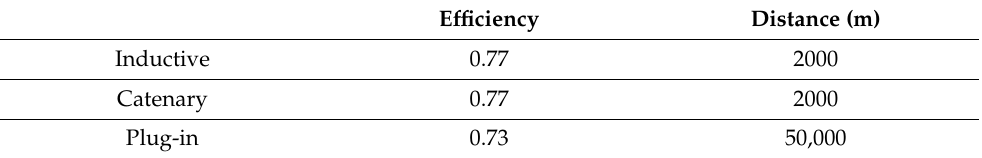
Figure 4. On the left, substations in proximity to the highway. On the right, the result of the SSA. In Table 3, the efficiencies and distances [24] of traction substation (or charging stations for plug-in scenario) are presented. Table 3. Characterization of the charging infrastructure.